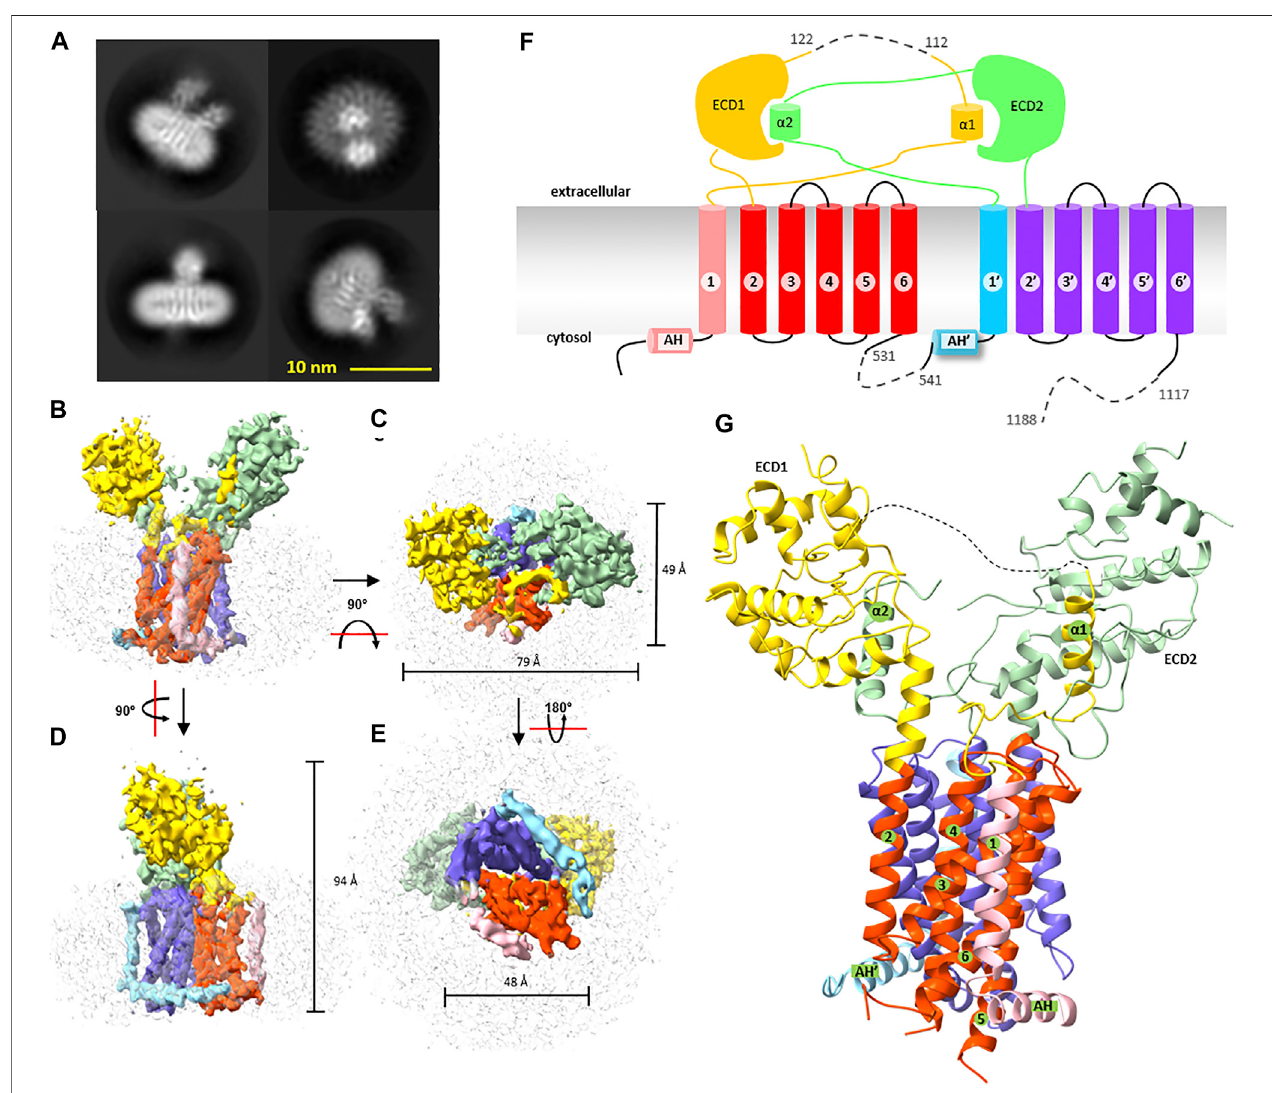
FIGURE 2 | Cryogenic electron microscopy structure of wb Disp. (A) Typical 2D class average of the cryo-EM particles. (B – E) Different views of the 3D map reconstructed from 62,850 particles. The density of the micelles is colored grey. Various parts of the protein are colored as in (F) and (G) . (F) Membrane topology of wb Disp. Numbers with and without prime symbols indicate transmembrane helices in the N-terminal half and C-terminal half, respectively. ECD: extracellular domain; AH: amphipathic helix. Dashed lines denote deletion. (G) The overall structure of wb Disp. Various parts as in (F) are labeled, when